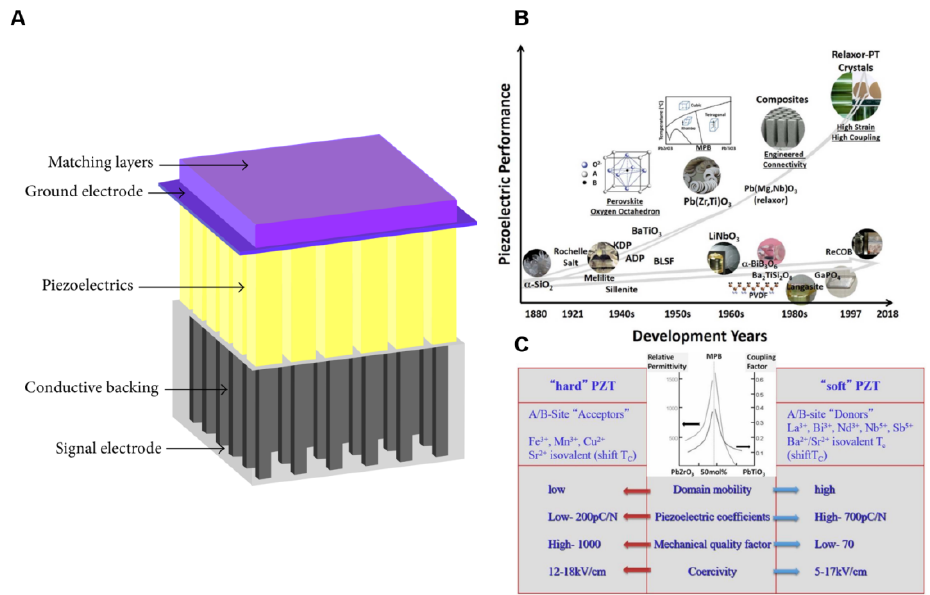
Figure 1. ( A ) Structure of a single-unit type matrix transducer. ( B ) Development of piezoelectric materials with mile-stones/breakthroughs. ( C ) Comparison of the “hard” and “soft” PZT ceramics. Basic structure of ultrasound transducers and development of the piezoelectric layer material [15]. Adapted with permission from Ref. [15]. Copyright 2018, Springer Nature.